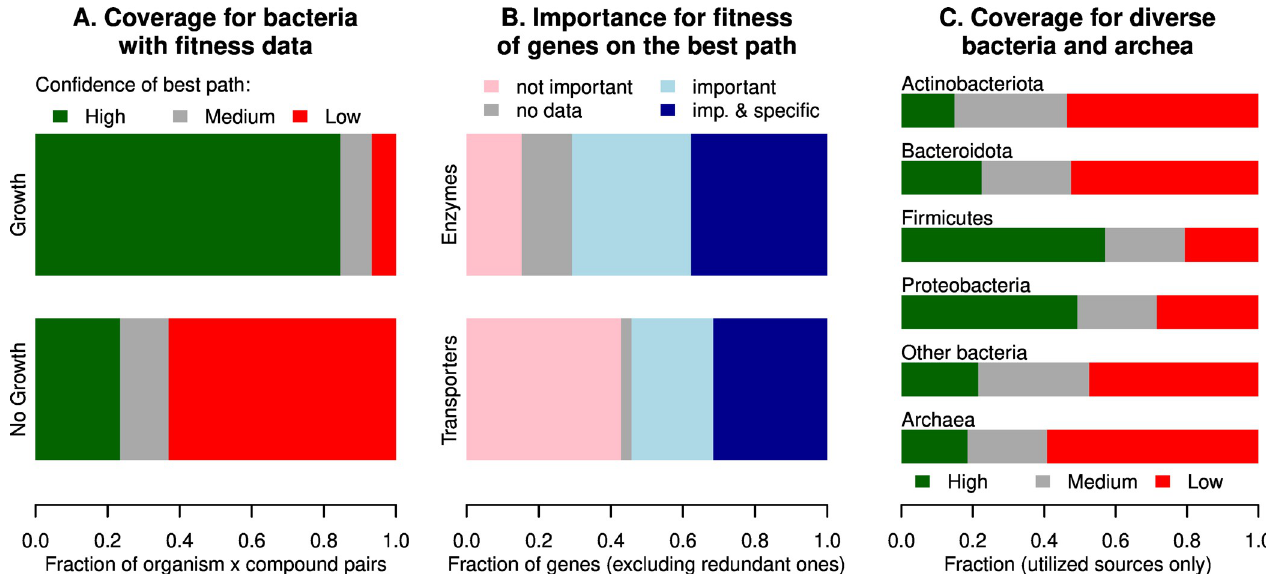
Fig 9. Quality of GapMind’s results. (A) Confidence of the best path for utilized and non-utilized carbon sources, across 57 carbon sources and 29 heterotrophic bacteria with fitness data. A path is low confidence if it has any low-confidence steps (and similarly for medium confidence). Proportions are from 700 utilized cases and 953 non-utilized cases. (B) Whether high-confidence and non-redundant genes on the best path were important for fitness. Proportions are from 962 genes that encode transporters and 1,254 genes that encode enzymes. Genes lack fitness data if they have insufficient coverage by transposon insertions (usually these are essential or short genes). A phenotype is “specific” if the gene has little phenotype in most other conditions [4]. (C) Confidence of the best path for utilized carbon sources across diverse bacteria and archaea. The phylum assignments are from the Genome Taxonomy Database [49], and “other phyla” includes 14 phyla with less than 100 organism x compound pairs each. There were 54 pairs for